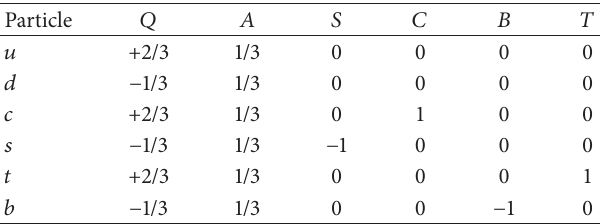
Table 2: SM additive quantum numbers for